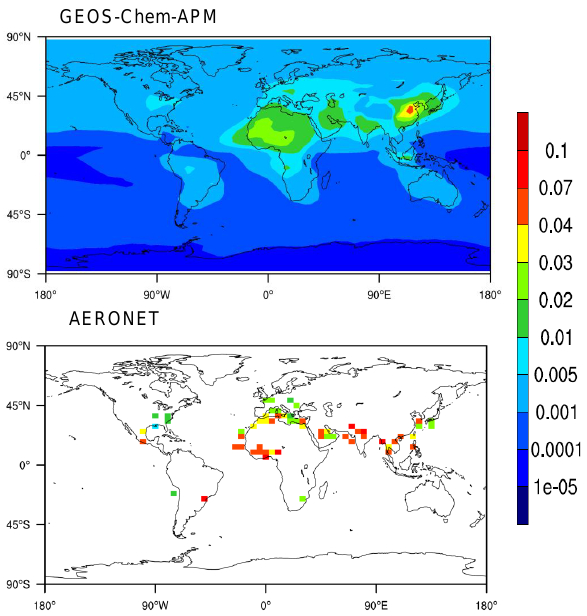
Fig. 4. Annual averaged (year 2006) aerosol absorption optical depth (AAOD) from GEOS-Chem-APM (top) and AERONET ob- servations (bottom) at